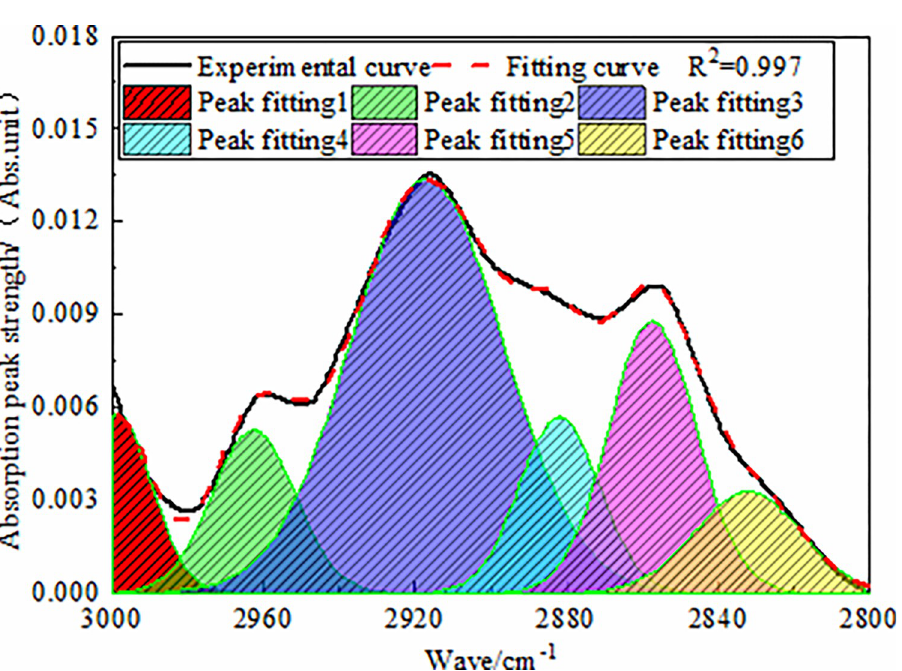
Fig 4. FT-IR fitting spectra of anthracite in 3000–2800 cm -1 band.